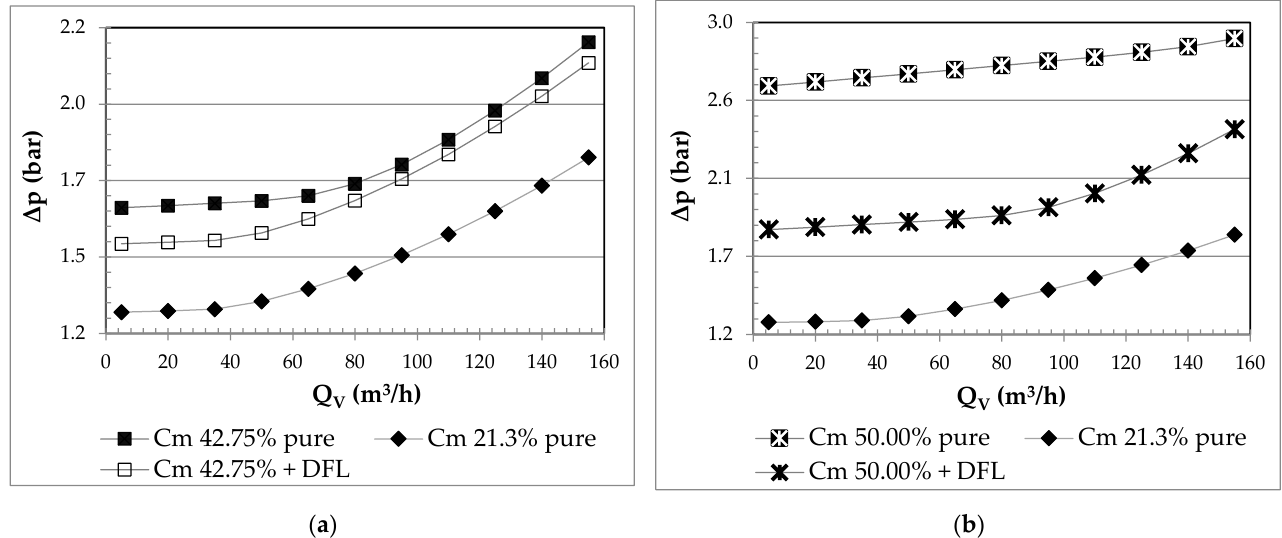
Figure 4. The results of frictional pressure drop calculations for hydromixtures of selected solid phase concentrations: ( a ) 42.75%, and ( b ) 50.00%.